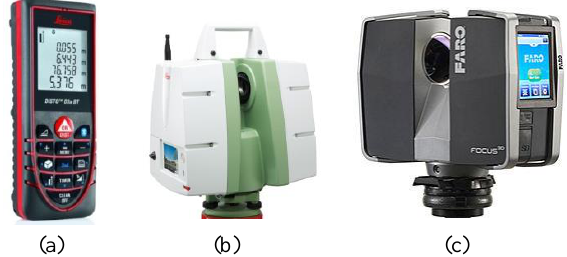
Figure 8: Leica Disto D3a BT hand-held laser meter (a); Leica C10 (b) and Faro Focus 3D 120 (c) terrestrial laser scanners.